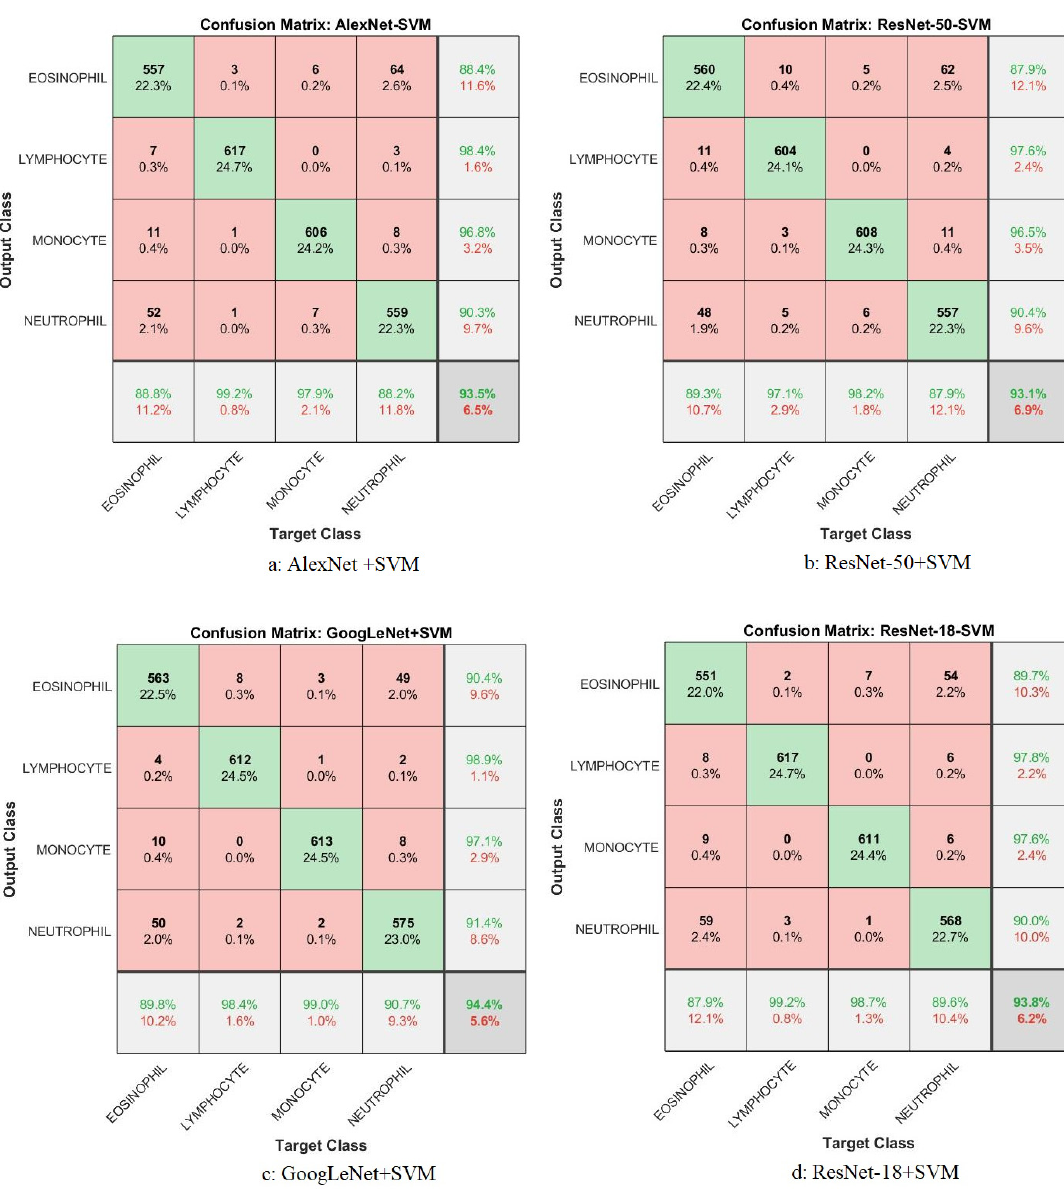
Figure 19. Confusion matrix display showing the white blood cell type dataset calculated using ( a